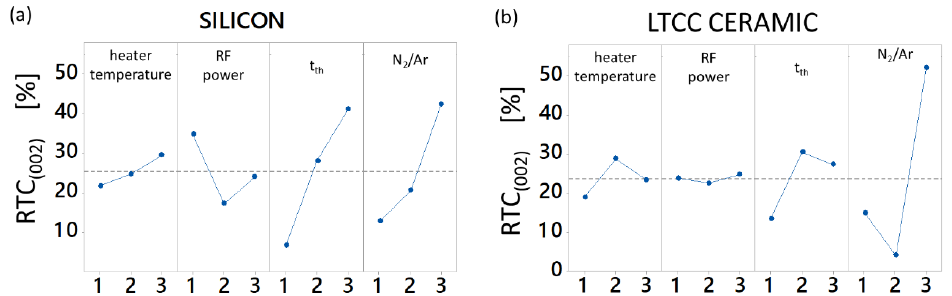
Figure 1. Analysis of Means (ANOM) plot with relative texture coefficient (RTC) (002) as evaluation criterion (maximum optimization): ( a ) for silicon substrates; ( b ) for ceramic substrates.